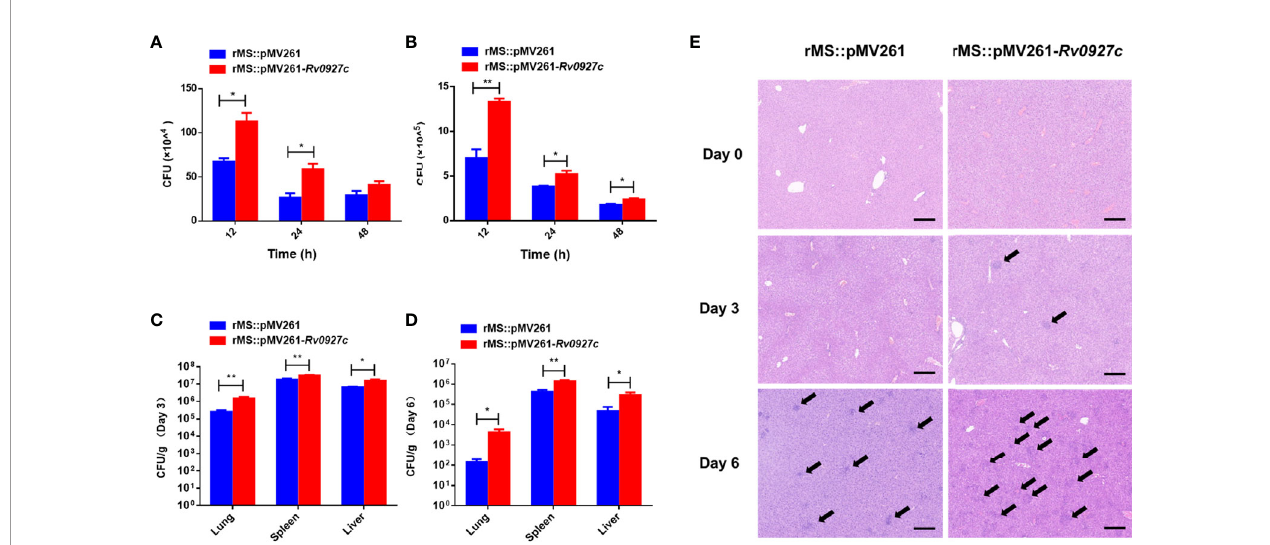
FIGURE 7 | Rv0927c enhances M. smegmatis survival and liver pathology of infected mice. (A, B) RAW264.7 cells and BMDMs were infected with rMS::pMV261 and rMS::pMV261- Rv0927c (MOI=10). Cells were lysed at the indicated time by 0.05% Triton X-100 and the bacterial number was determined by 7H10 plate count. (C, D) C57BL/6 mice were given 5×10 7 CFU of recombinant M. smegmatis by intraperitoneal injection. On day 3 or 6 post-infection, mice were sacri fi ced and the lungs, spleens, and livers were collected for analysis of CFUs. (E) Hematoxylin and eosin (H&E) staining of the livers of mice treated as in (C, D) ; arrows indicate foci of cellular in fi ltration. Scale bars, 200 m m. * P < 0.05 and ** P < 0.01 (unpaired two-tailed Student ’ s t test). Data are representative of one experiment with two independent biological replicates (mean and sem of n = 5 mice per